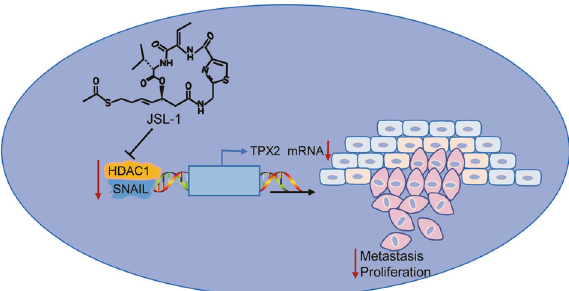
Fig. 9 The schematic map of the regulatory network HDAC1/ Snail/TPX2 in CC. JSL-1 blocks the enrichment of HDAC1 and Snail on the TPX2 promoter and then downregulates TPX2 expression by inhibiting HDAC1, thus impeding the growth and metastasis of